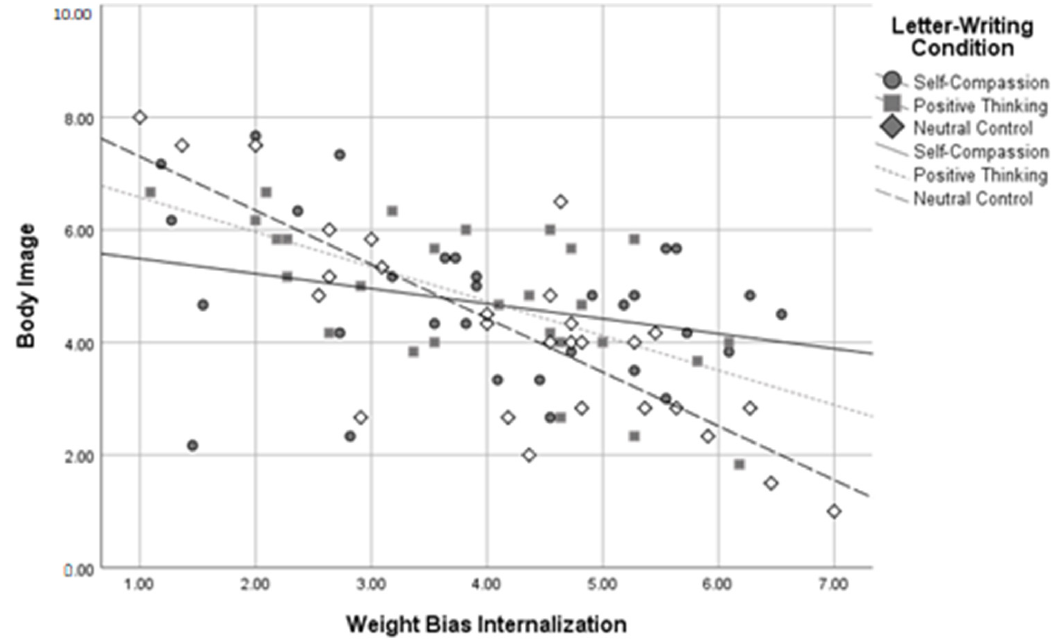
Figure 6. Le tt er-Writing Condition*Weight Bias Internalization Interaction on Body Image.